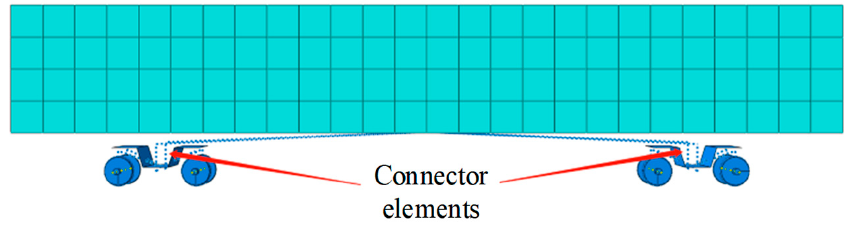
Figure 19. FEM of single train and connector elements.